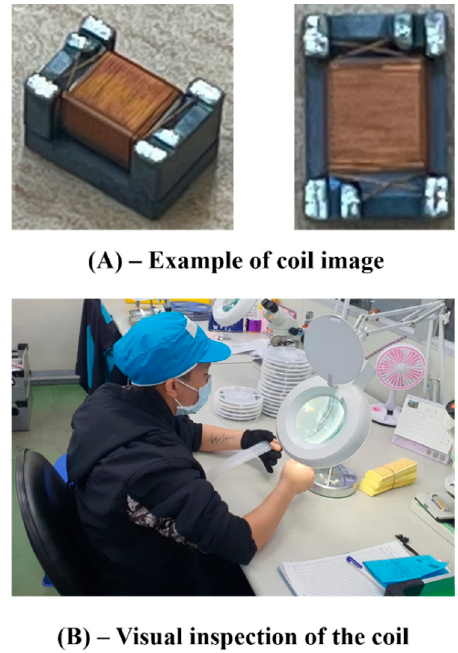
Figure 1. Example of coil—visual inspection.